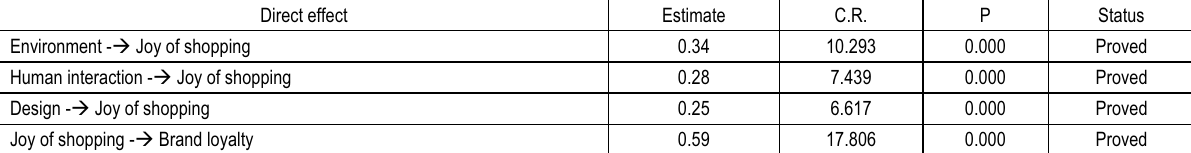
Table 7. Direct standardized regression coefficients